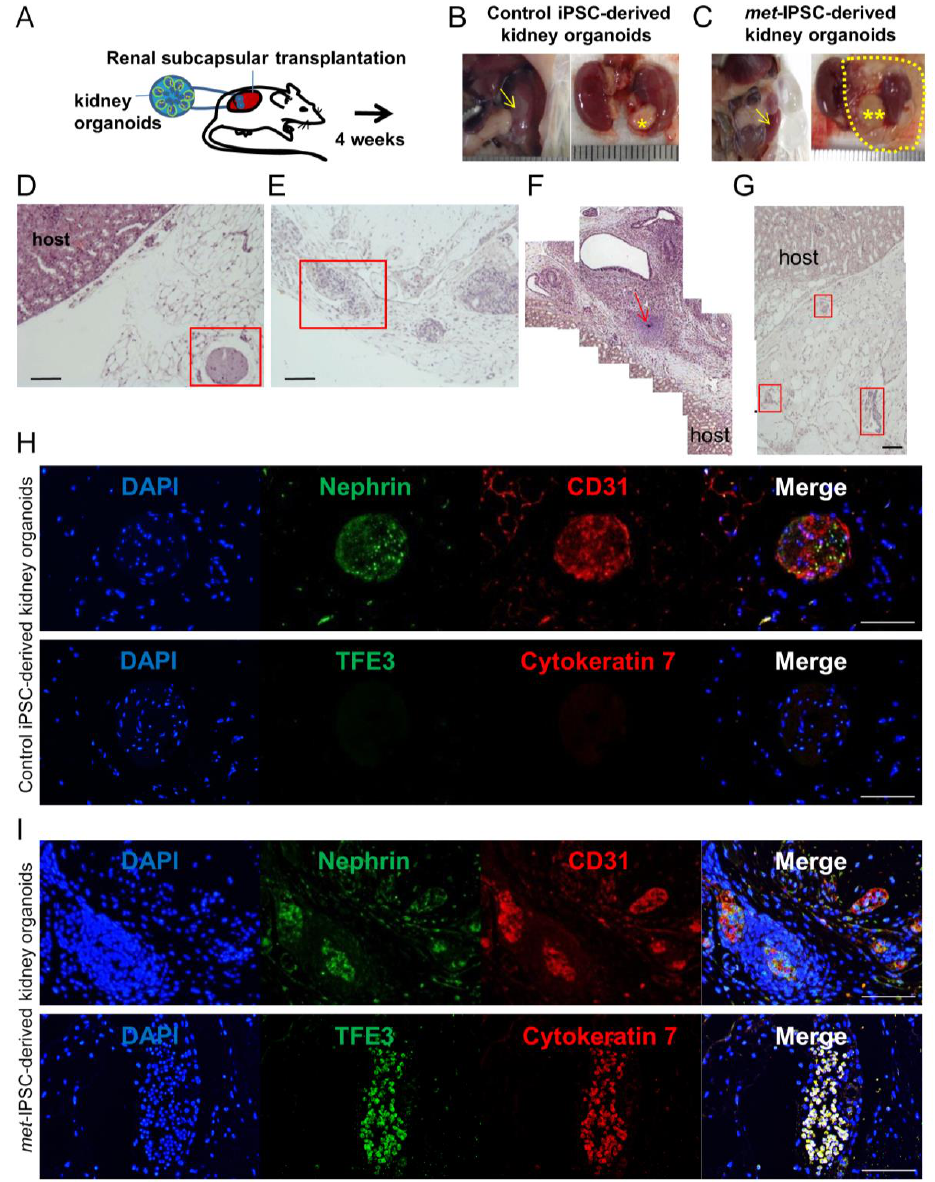
Figure 5. Analysis of tumors generated by transplantation of kidney embryoid bodies. ( A ) Experimental protocol used. ( B , C ) Macroscopic aspect of kidney NSG mouse 1 month after transplantation of control (*) or met -IPSC-derived kidney embryoid bodies (**), mouse kidney (arrow). ( D , H ) Pathological analysis of tumors generated by transplantation of control kidney embryoid bodies at 1 month showing the presence of normal embryoid bodies-like structures expressing kidney di ff erentiation markers. ( E – G , I ) Pathology of c- met -mutated tumors after transplantation of met -IPSC-derived kidney